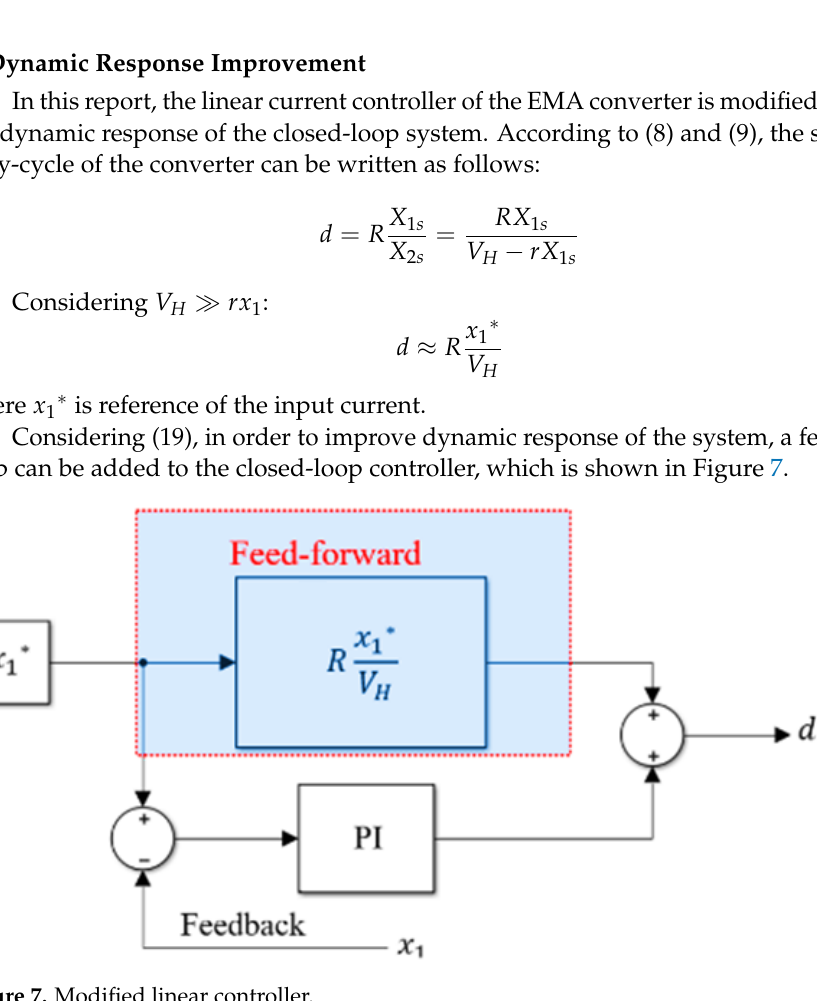
Figure 7. Modified linear controller.